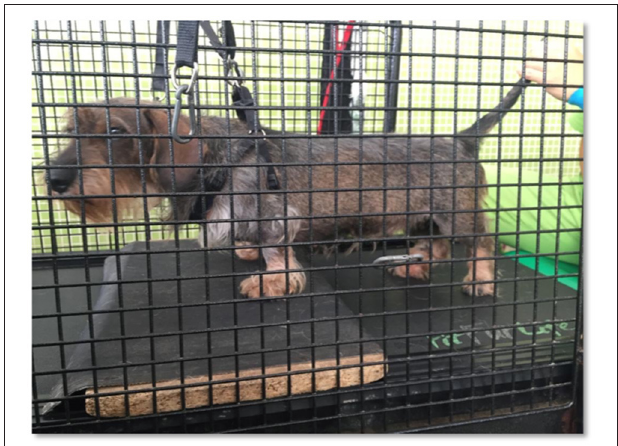
FIGURE 5 | Body weight-supported treadmill training with bipedal step training. Forelimbs stationary on a fixed platform above the belt.